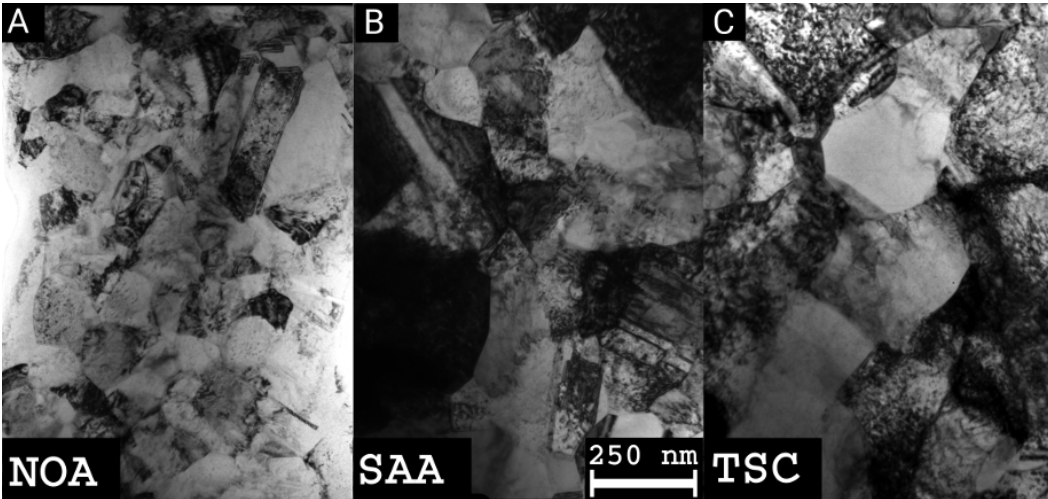
Figure 3. TEM images taken on samples NOA ( A ), SAA ( B ), and TSC ( C ) before heat treatments.